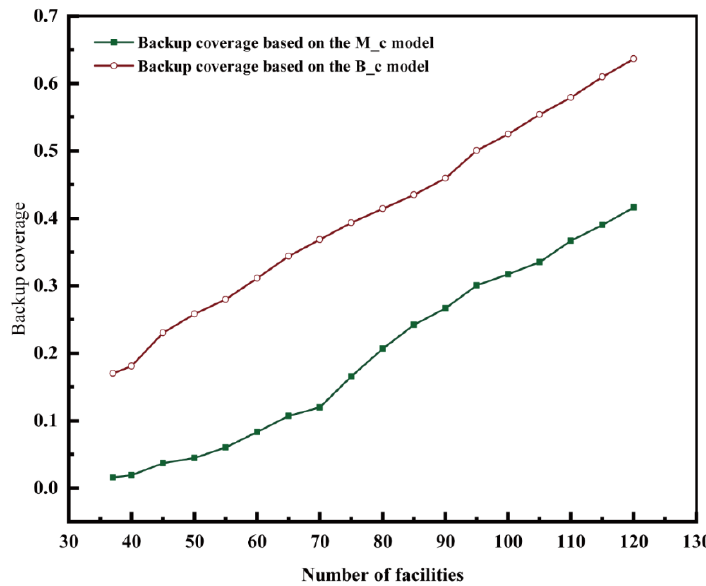
Figure 12. Comparison of backup coverage in the two models (MCM, BCM).